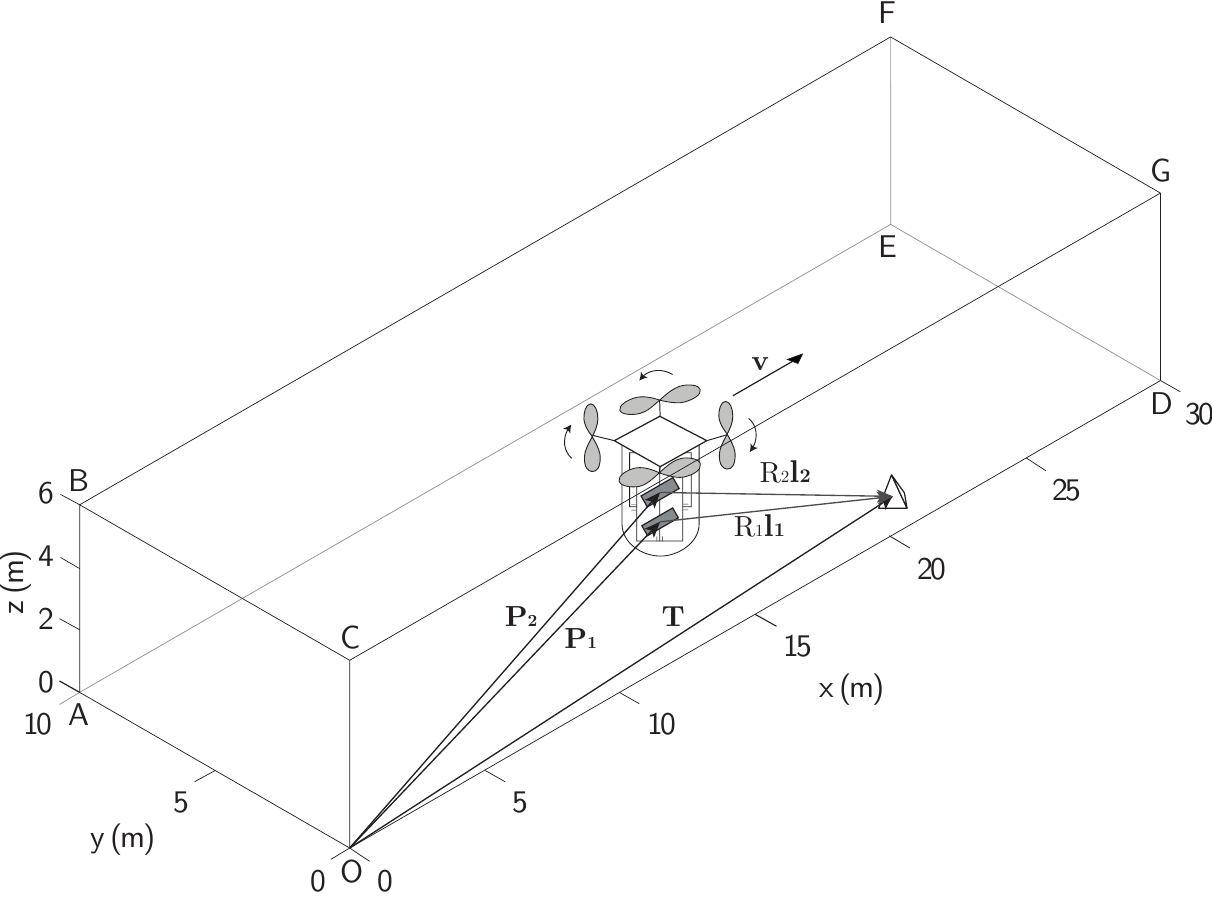
Figure 9. Platform and sensor moving in a simplified operational scenario. The platform and target position vectors, the line of sight unit vector, the velocity vector and the target distance to the antennas are depicted, too (not to scale, for